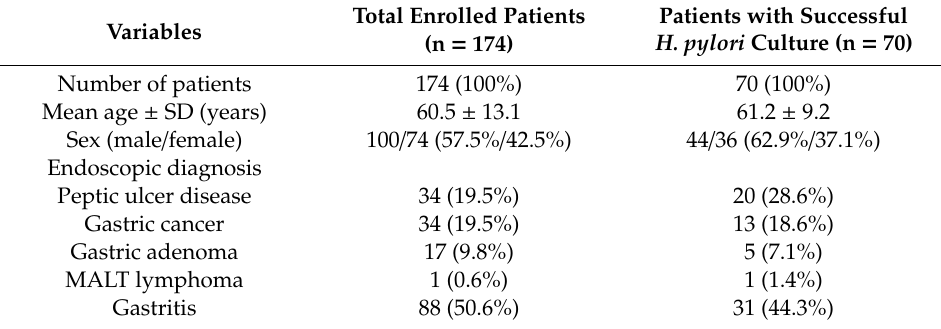
Table 1. Baseline characteristics of the study